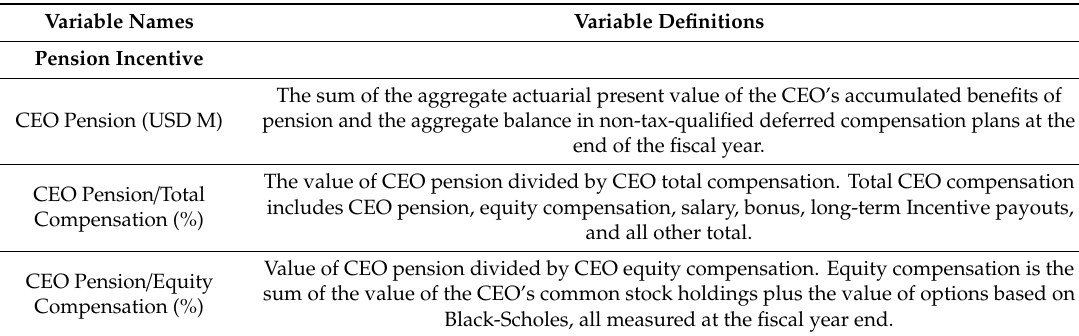
Table A1. Detailed definition of primary variables used in this